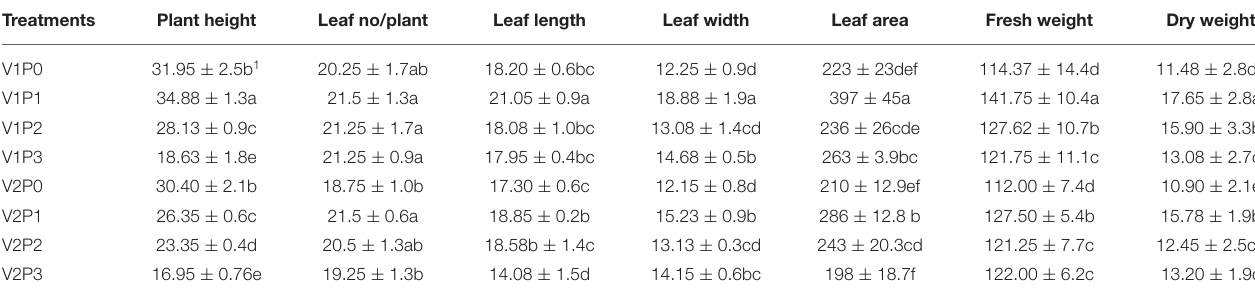
TABLE 3 | Growth characteristics (plant height, cm; number of leaves per plant; leaf length, cm; leaf width, cm; leaf area, cm 2 ; fresh and dry weight, g/plant) of two lettuce cultivars ( Lactuca sativa cv. Green Wave, V1; Lactuca sativa cv. New Red Fire, V2) grown in different organic growing media (P0: control, 100% soil; P1: 40% soil